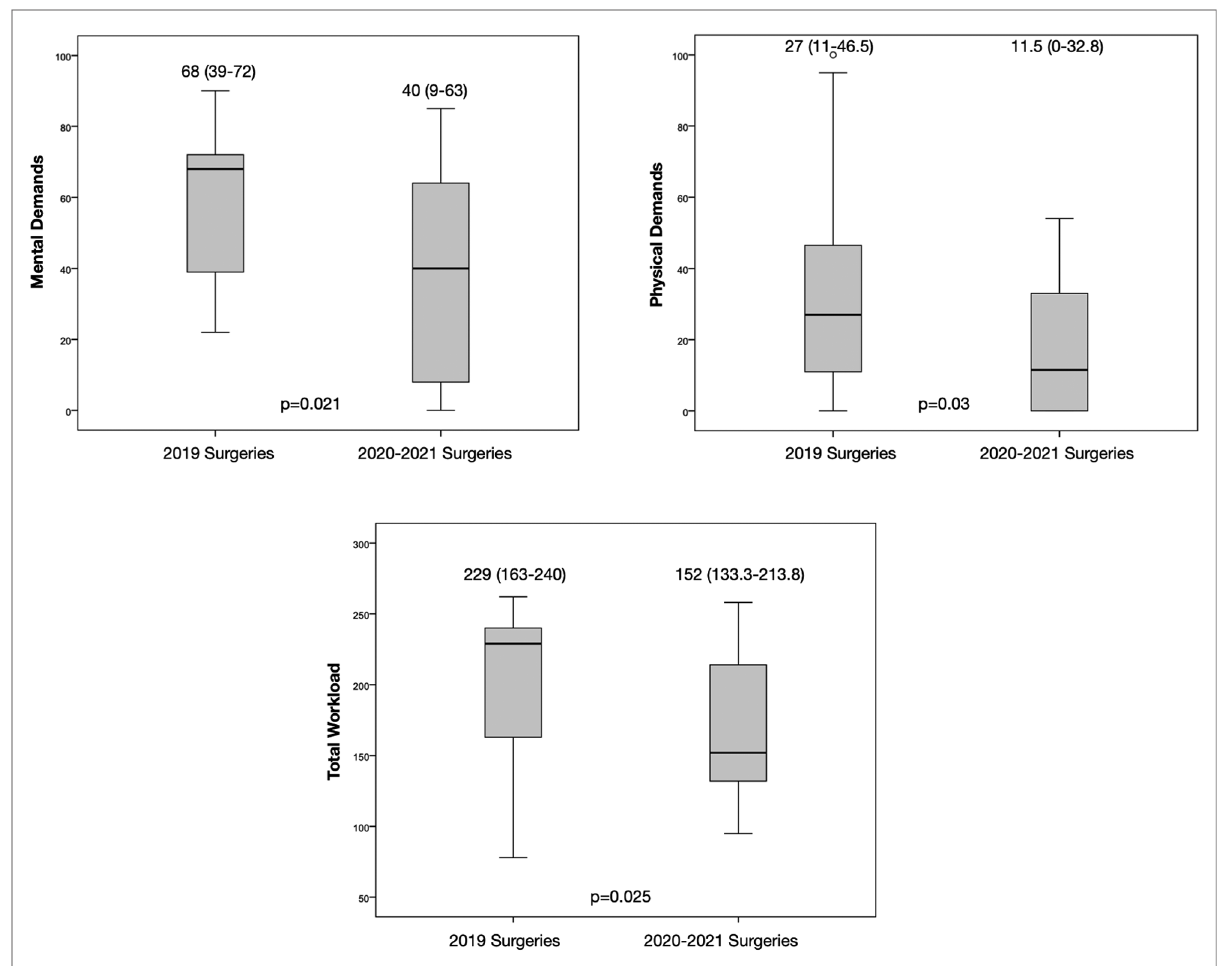
FIGURE 2 Boxplot comparing mental and physical demands and total workload between the two surgery